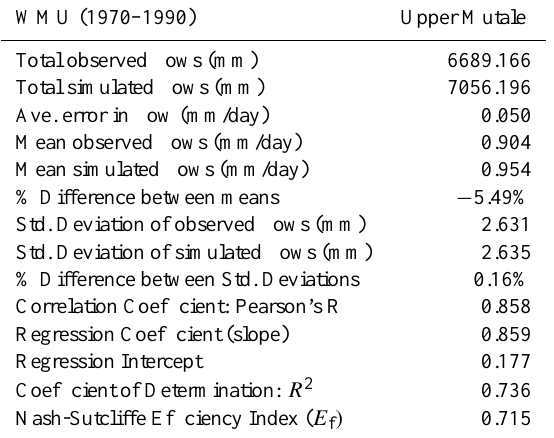
Table 8. Statistics of performance of the ACRU model Upper Breede Catchment: comparison of Daily Observed and Simulated